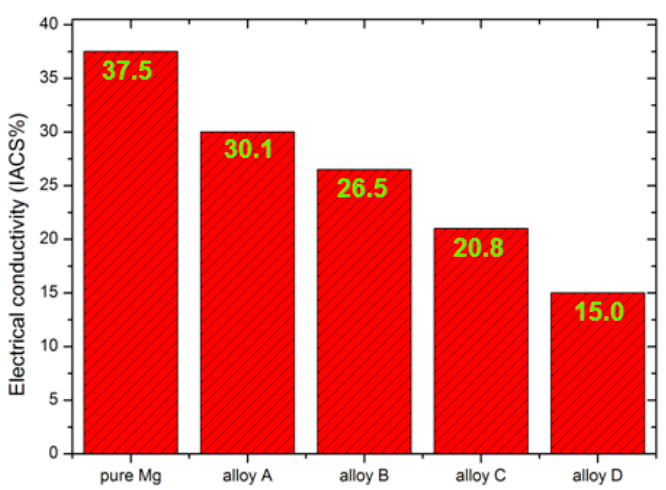
Figure 5. Quantitative electrical conductivities of the investigated Mg–Mg 2 Ni alloys system.